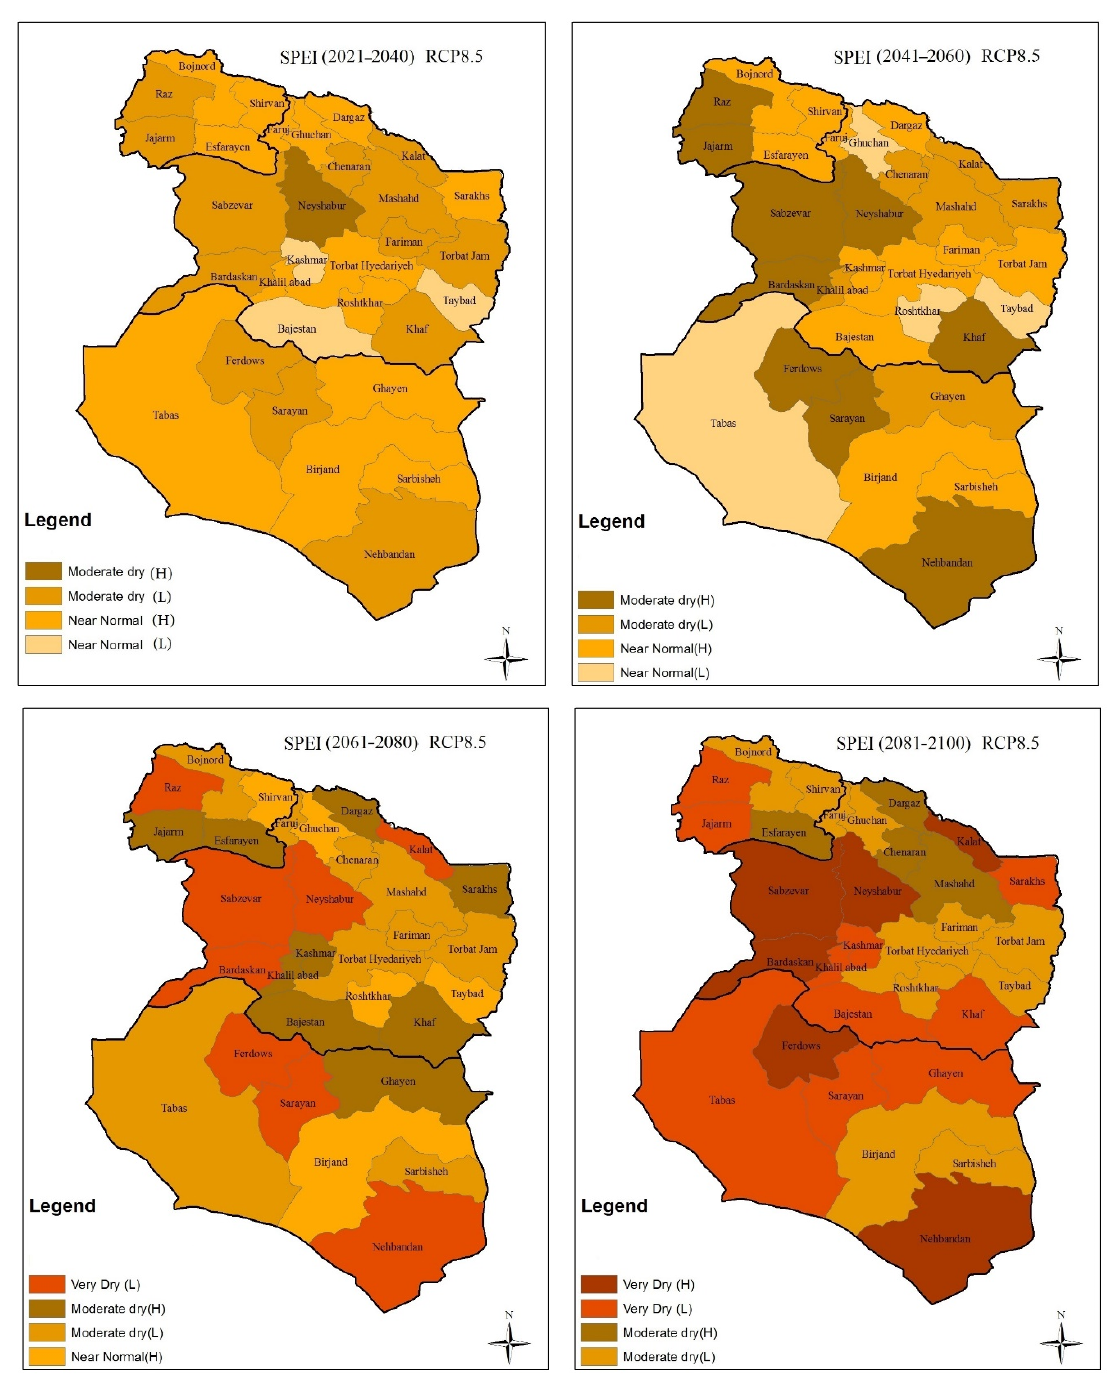
Figure 7. Future drought projection over study region using SPEI under RCP8.5 scenarios for 2021–2040, 2041–2060, 2061–2080 and 2081–2100.